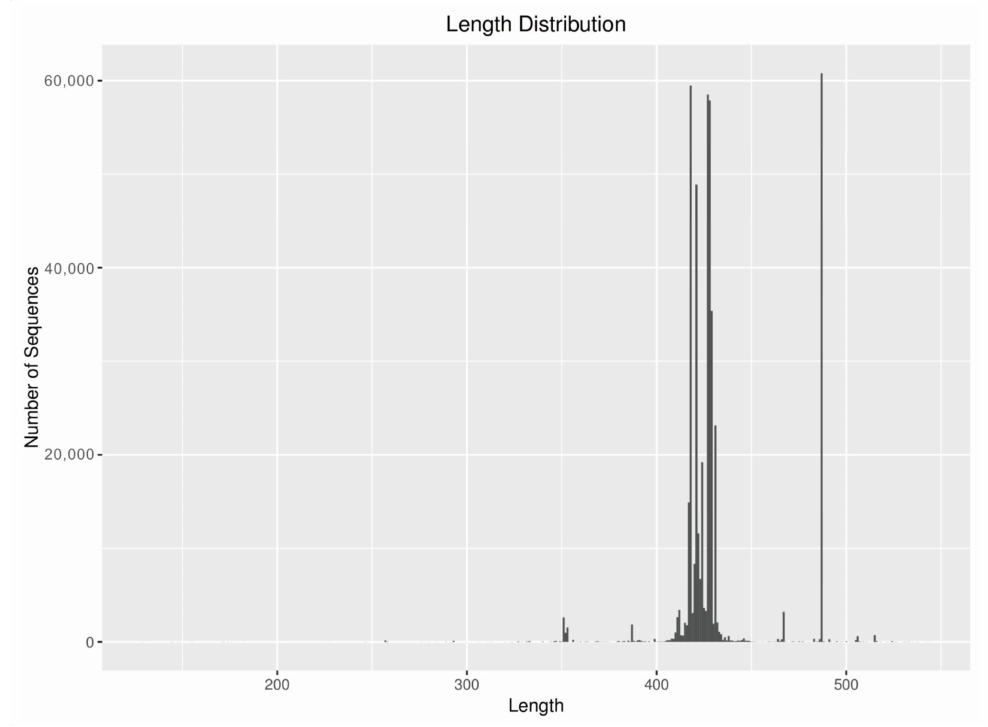
Figure 2. Sequence length composition